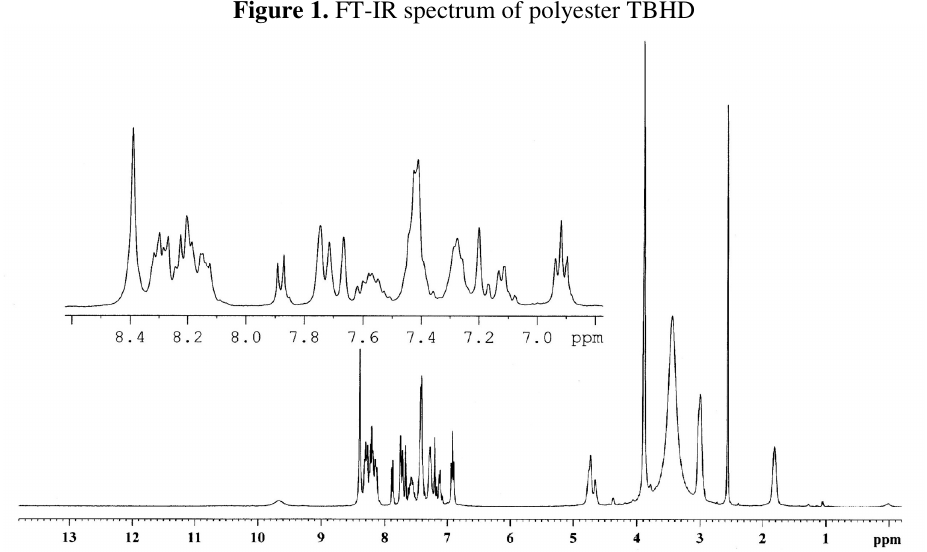
Figure 1. FT-IR spectrum of polyester TBHD